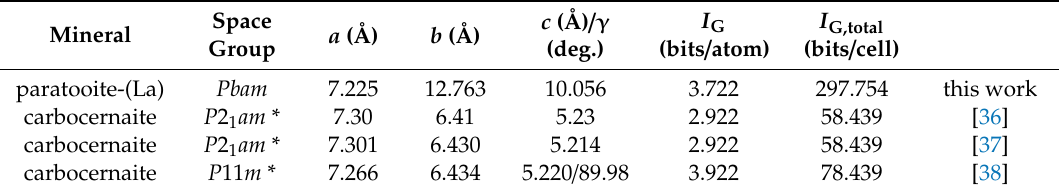
Table 7. Unit-cell parameters, space groups, and structural complexity parameters for paratooite-(La) and carbocernaite. Mineral